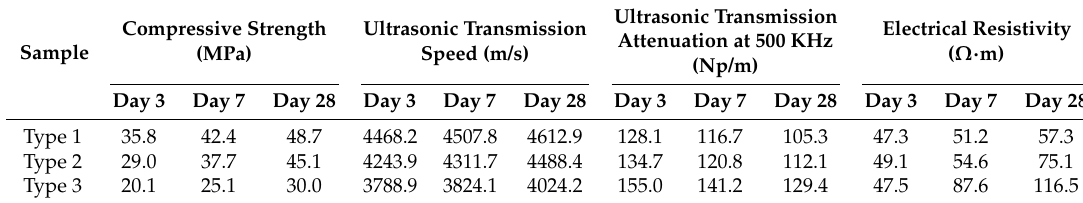
Table 2. Properties of concrete samples during the early stages.